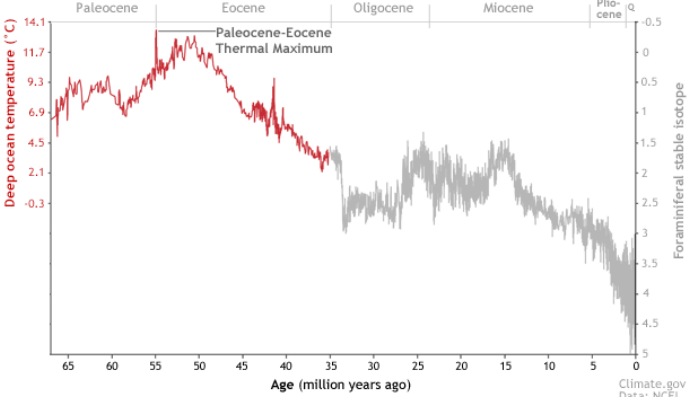
Figure 1. The deep ocean temperatures versus time, extended over a range of epochs from the Paleocene to the Pliocene. The temperatures in the distant past were calculated using oxygen isotope ratios from fossil foraminifera (one-celled protists, eukaryotic organisms), while the red part of the plot assumes an ice-free ocean and the gray part does not. A thermal maximum approximately 55 Myrs ago is clearly seen. The graph is by Hunter Allen and Michon Scott, using data from the NOAA National Climatic Data Center, courtesy of Carrie Morrill. For details see https://www.climate.gov/ news-features/features/models-and-fossils-face-over-one-hottest-periods-earths-history (accessed on 20 March